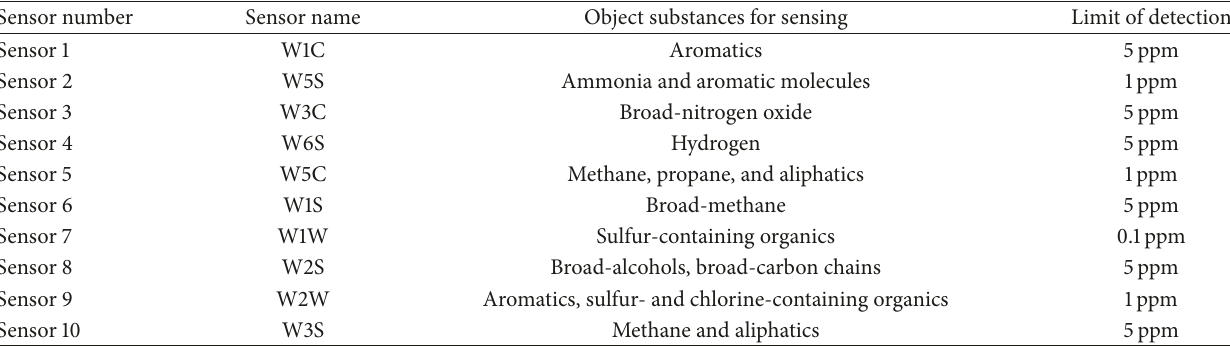
Table 2: Electronic nose sensors parameters of AIRSENSE